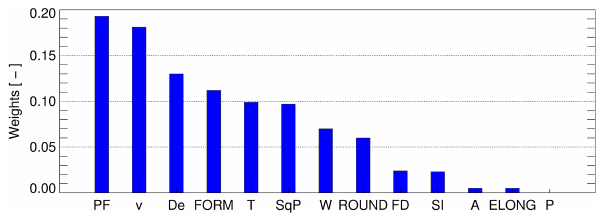
Figure 8. Weights d m of the 13 K m kernels, associated with the 13 particle descriptors used in the present